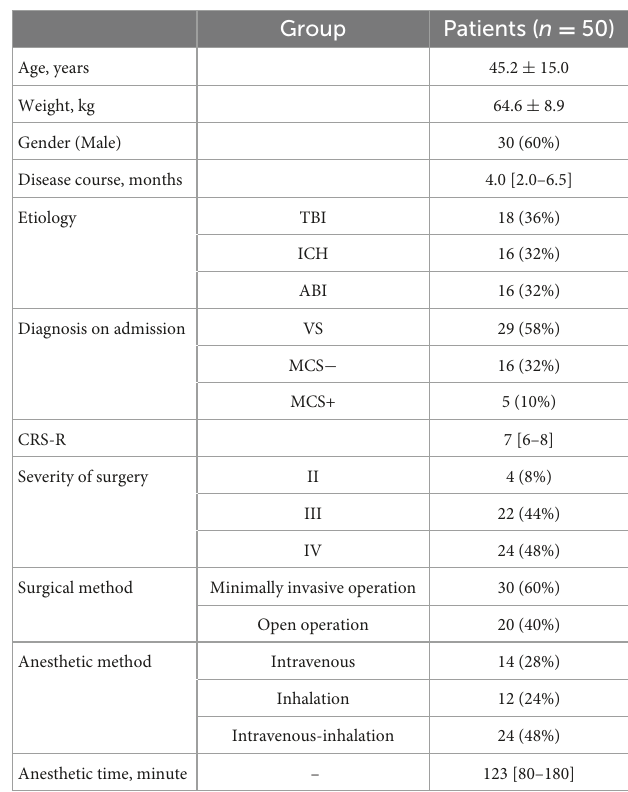
TABLE 1 Baseline demographic and clinical characteristics of the